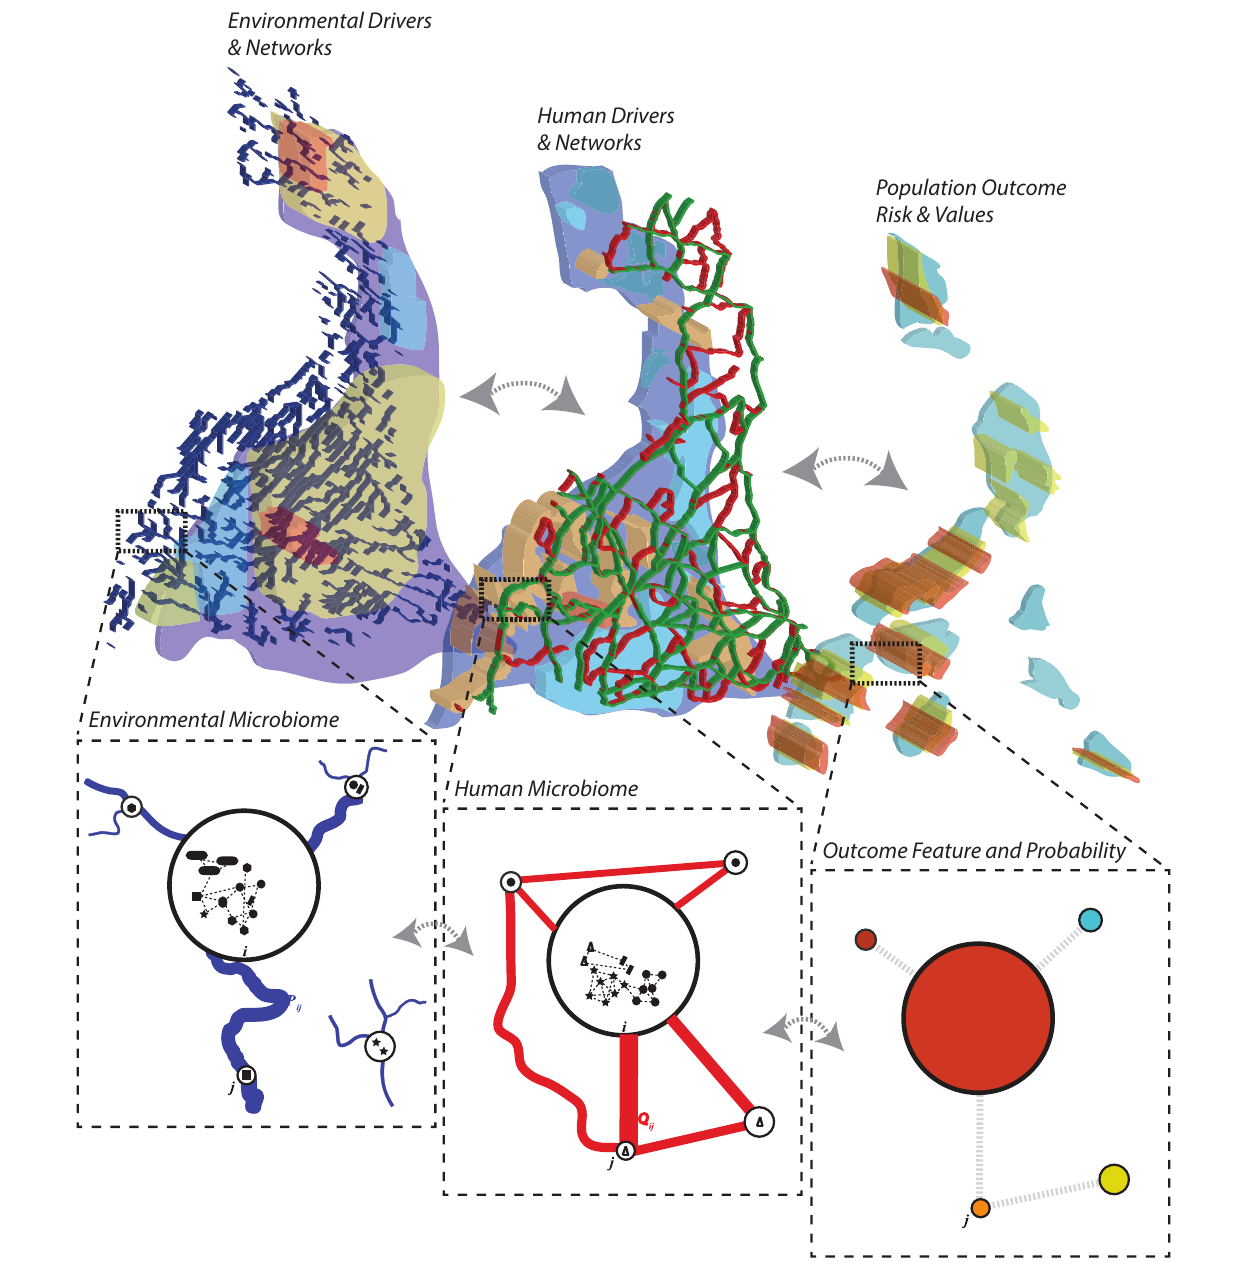
FIGURE 1 | Metacommunity approach for studying the ecology and evolution of the microbiome. The ecosystem is discretized in communities (nodes) connected via environmental and human links representing relevant connection determining the spread of species and/or hosts such as river networks and human mobility networks (Convertino et al., 2009; Coyte et al., 2015; Bashan et al., 2016). Local/nodal environmental and human features constitute the likely niche of species to exist in a community. The human-environmental microbiome nexus (HEM), that is the multiplex network between functionally relevant microbiome networks in the human population and the environment, determines some population outcomes of interest (such as diseases in human populations, and other ecological outcomes such as collective population abundance and functional diversity in animal populations). Each node of the community can contain a detailed characterization of the microbiome interaction network or graph (see Figure 4 ). Systemic inter-community networks can also be inferred from information theoretic models (Convertino and Valverde, 2019; Li and Convertino, 2019) or statistical models based on interdependence of microbial